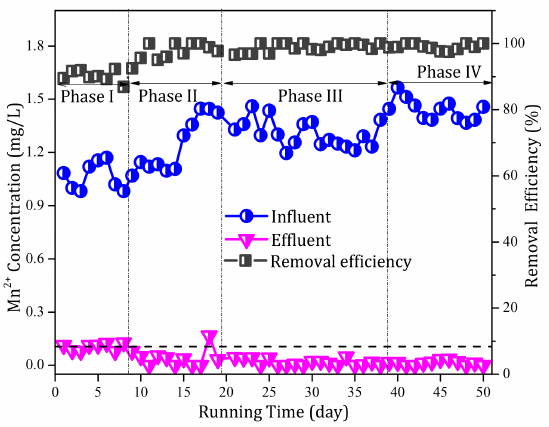
Figure 4. Profiles of the manganese (Mn 2 + ) removal performance over the continuous operational period of the pilot filter